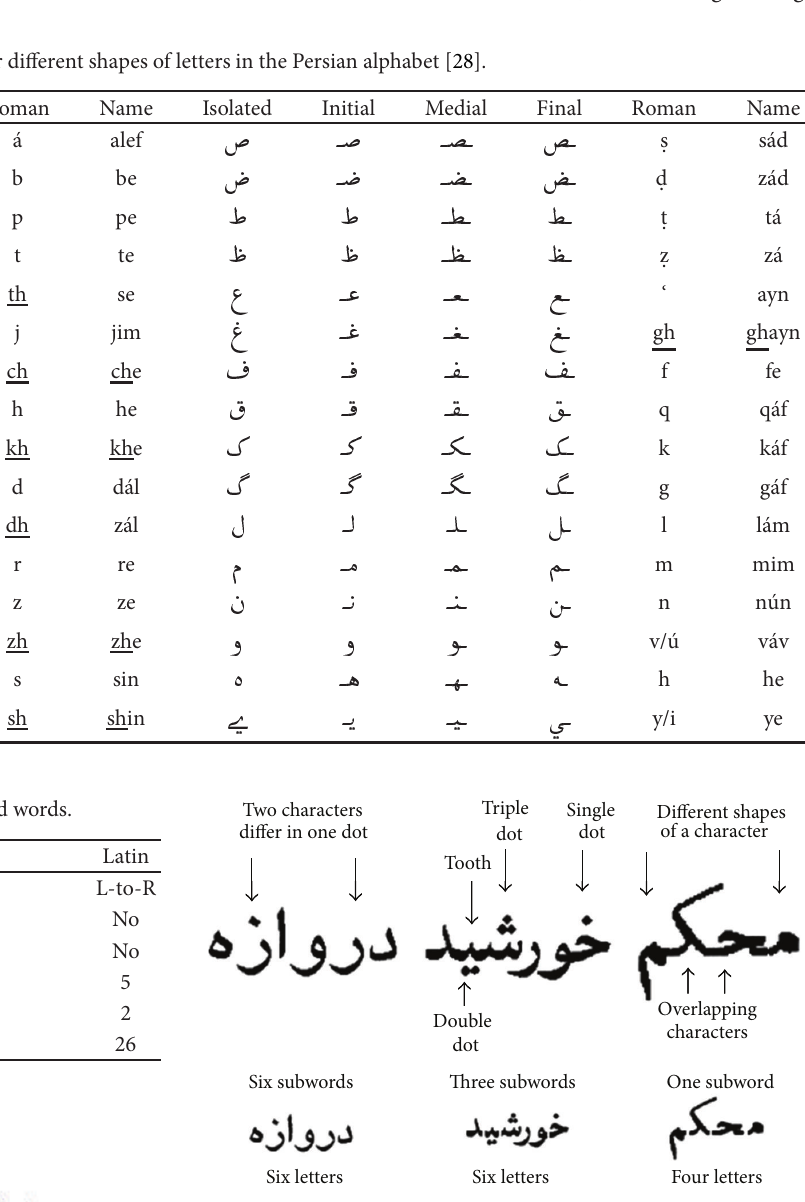
Figure 2: Some features of Farsi script